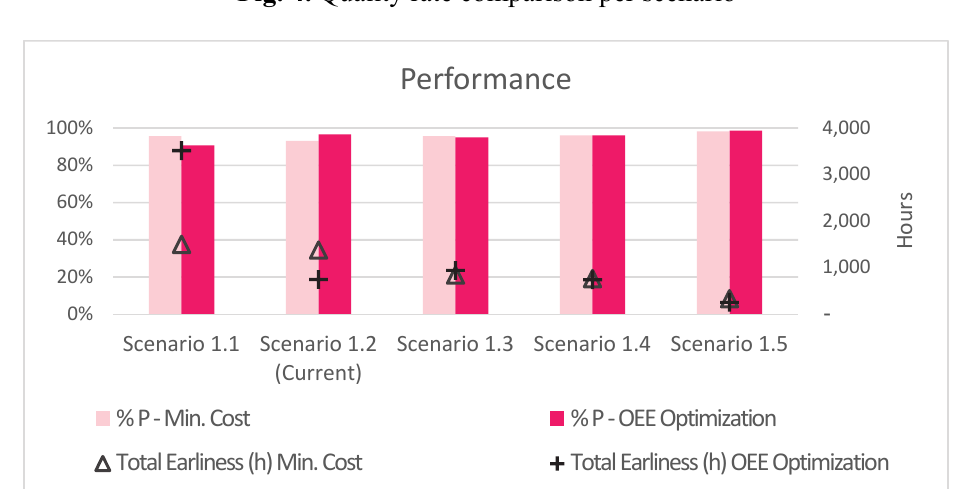
Fig. 4. Quality rate comparison per scenario